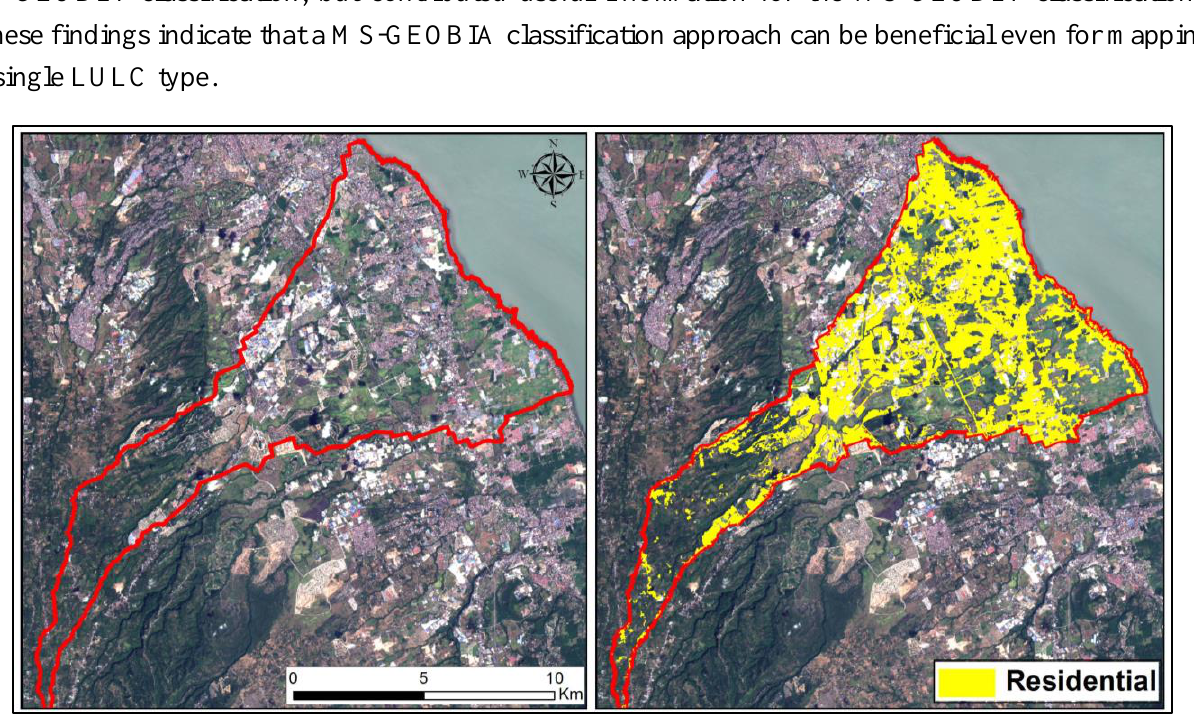
Figure 4. Study area image and the three-level MS-GEOBIA classification